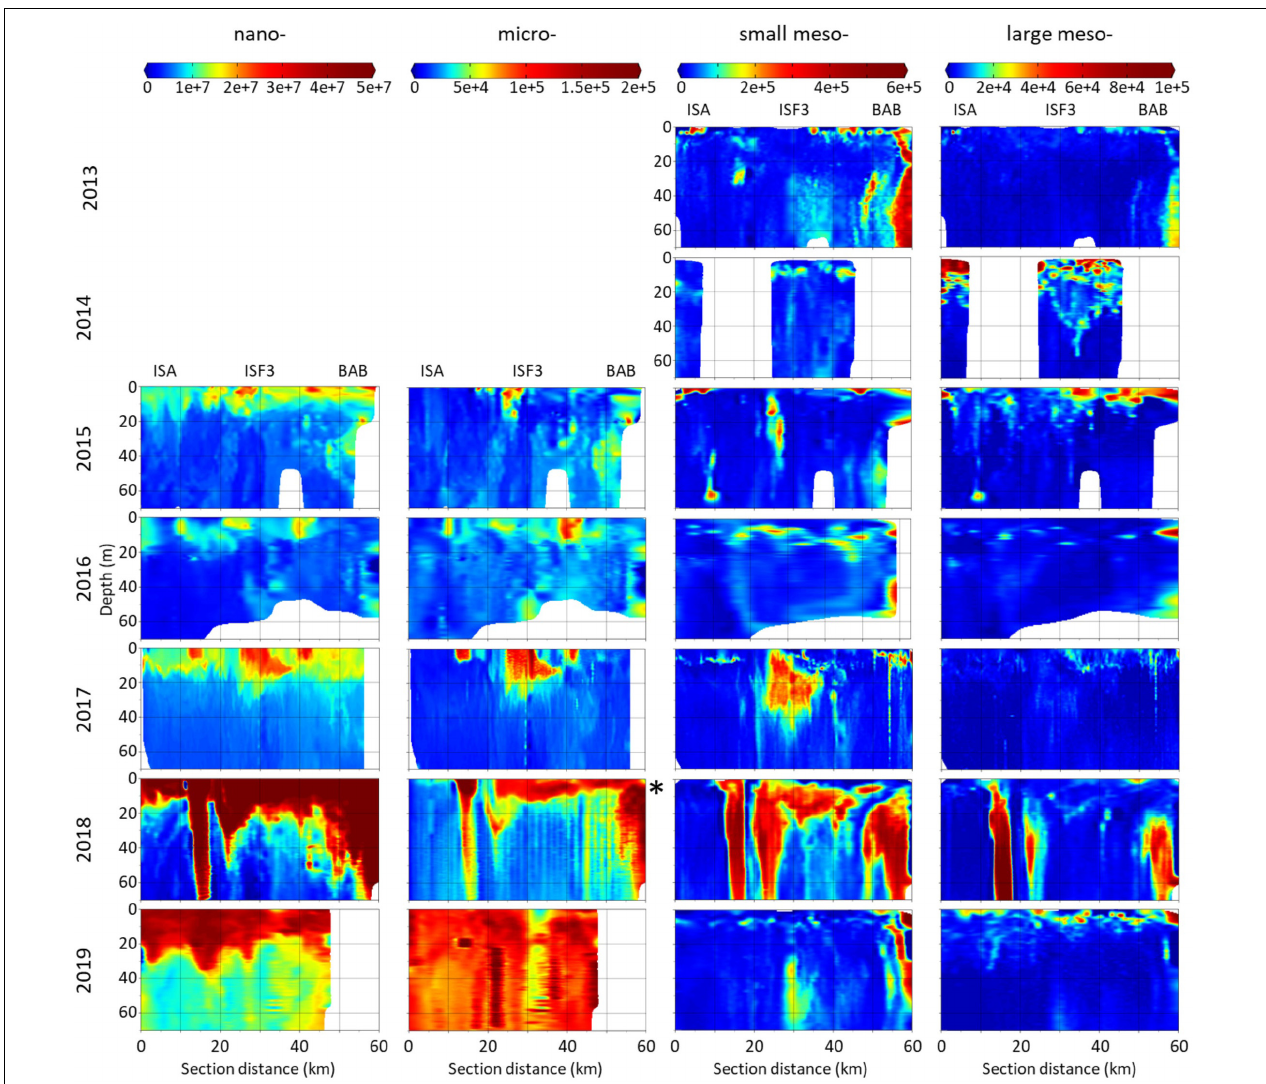
FIGURE 3 | Distribution of abundance (counts · m − 3 ) of P&P classified into four size fractions: nano-, micro-, small meso- and large meso- in the upper water column along Isfjorden transect from ISA station (left side of each graph) up to BAB station (right side of each graph) in seven consecutive mid-summers (2013–2019). Note different scales between size fractions. In 2018 the abundances of micro- fraction were one order of magnitude higher than in other years ( ∗ ). Data for nano- and micro- fractions (LISST) were not collected in 2013 and